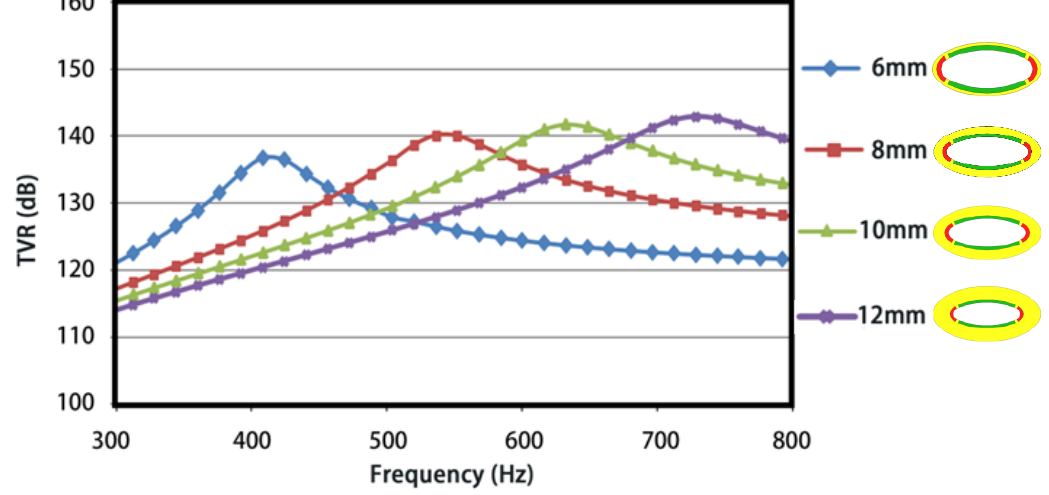
Figure 11. Influence of the shell thickness on the TVR.